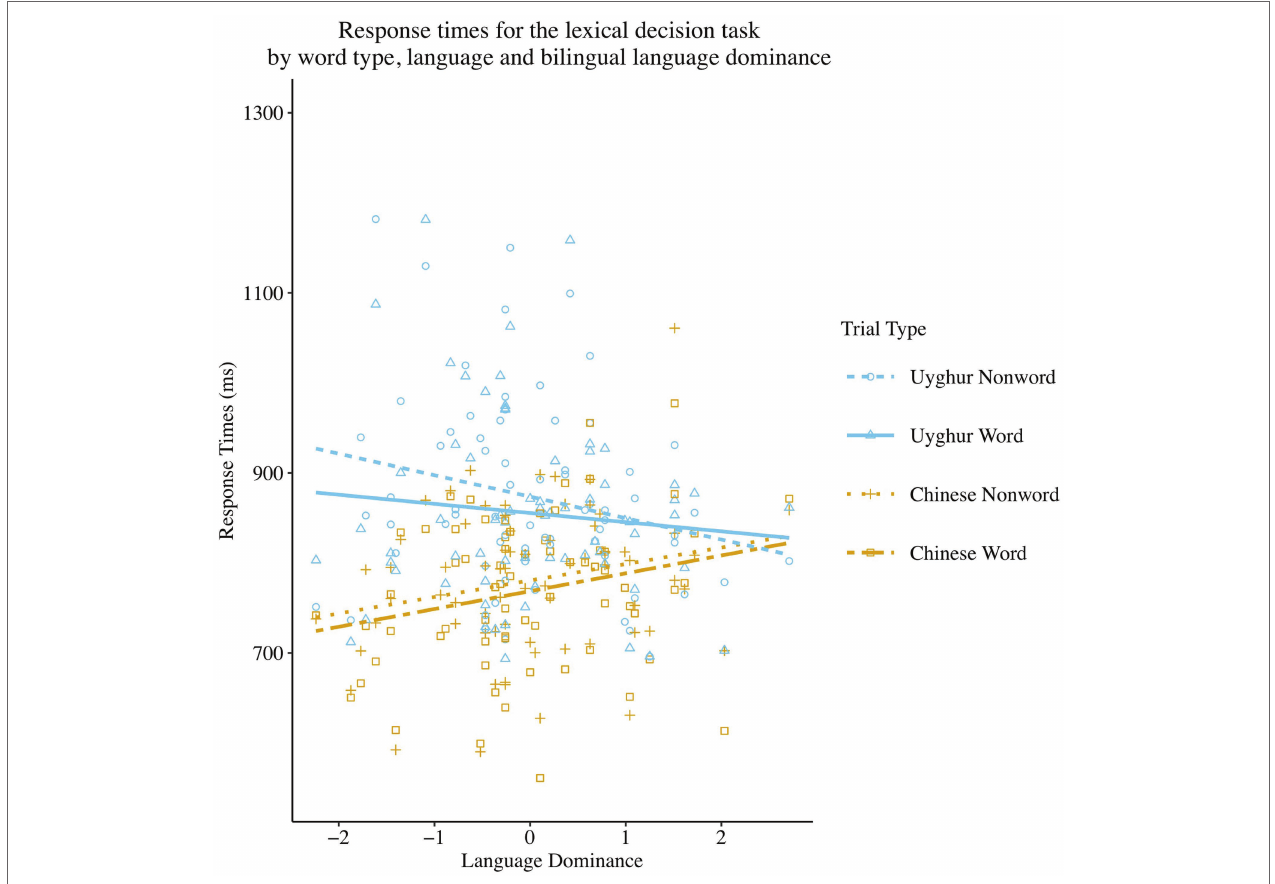
FIGURE 2 | Scatterplot and regression fit lines demonstrating the relationship between Language Dominance and mean response times at all the combinations of variables of Language and Word Type in the lexical decision task. The score on the x-axis closer to or above +1 means a higher dominance in L1, while the score closer to or below − 1 means a higher dominance in L2.